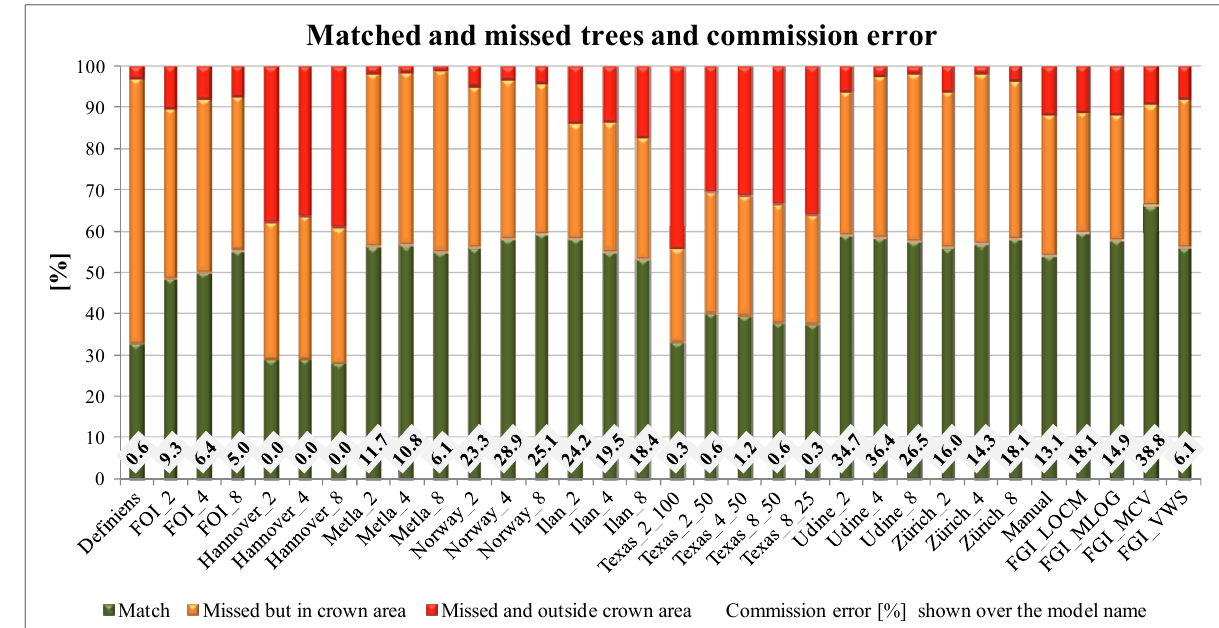
Figure 6. The percentages of matched and missed trees and the commission error (extra trees in the